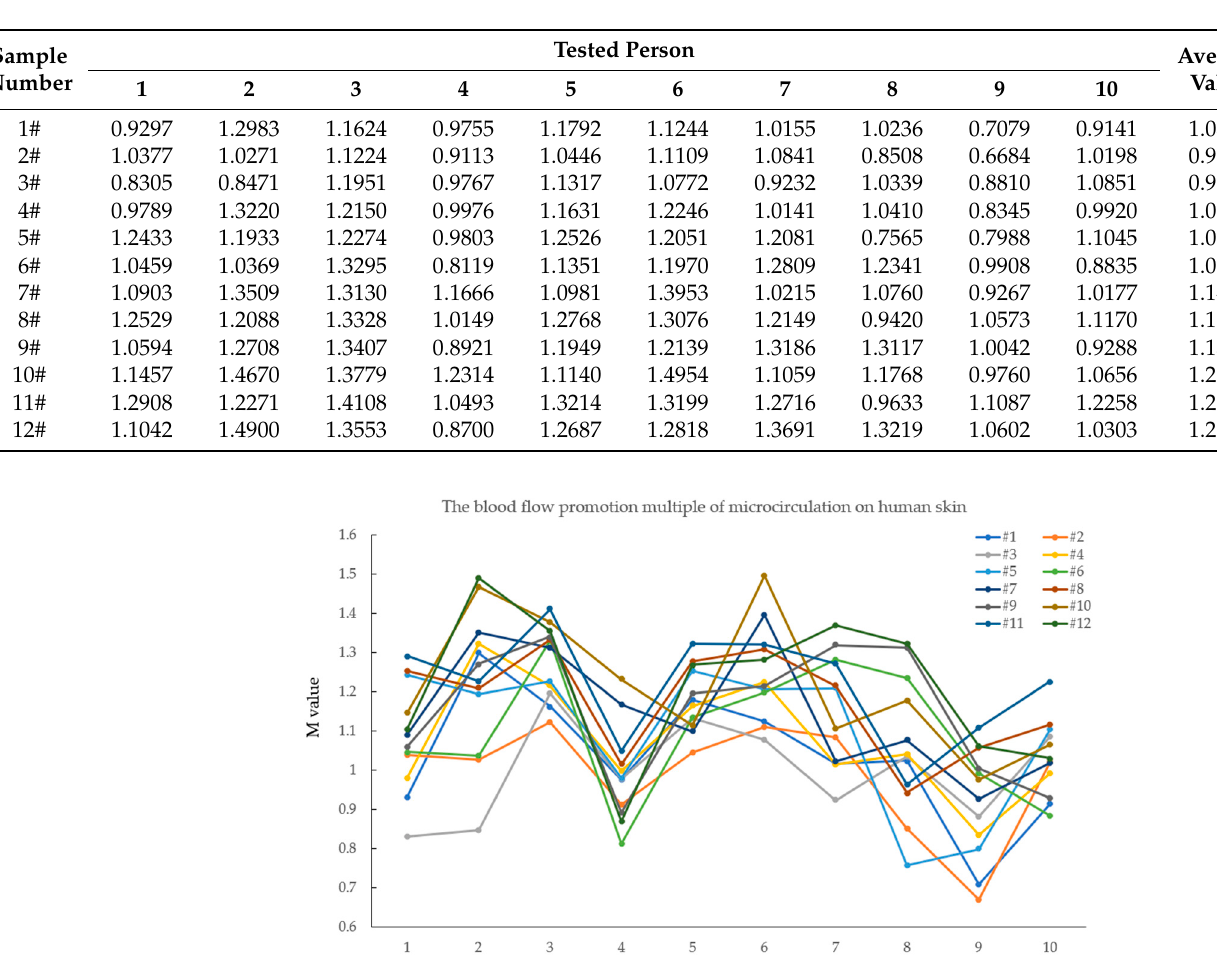
Table 4. Blood-flow promotion multiple and arithmetic mean value of each sample to skin microcir- culation.